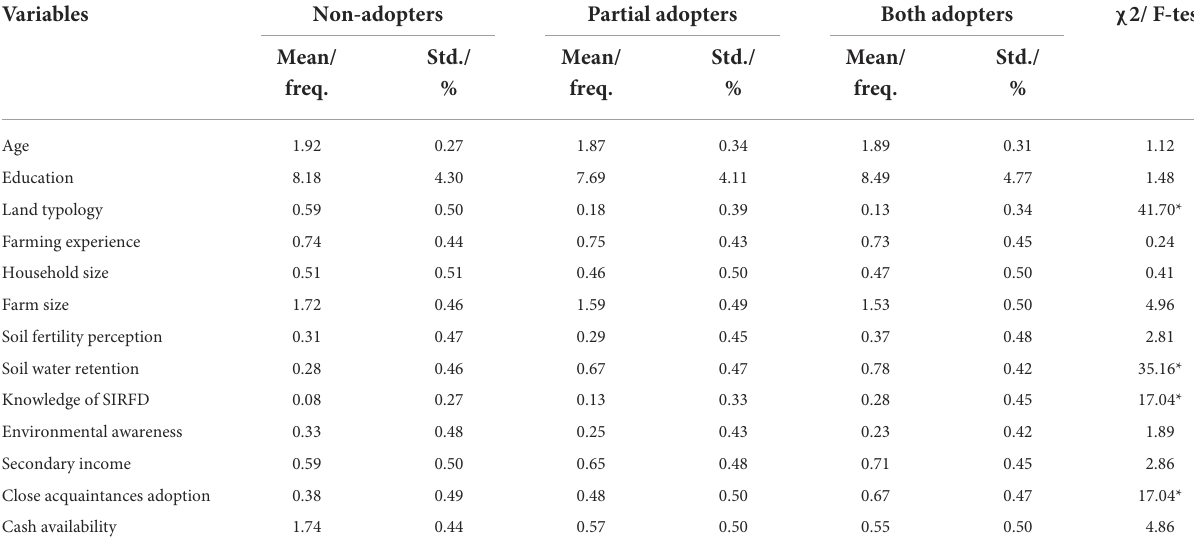
TABLE 2 Descriptive statistics of the explanatory variables.